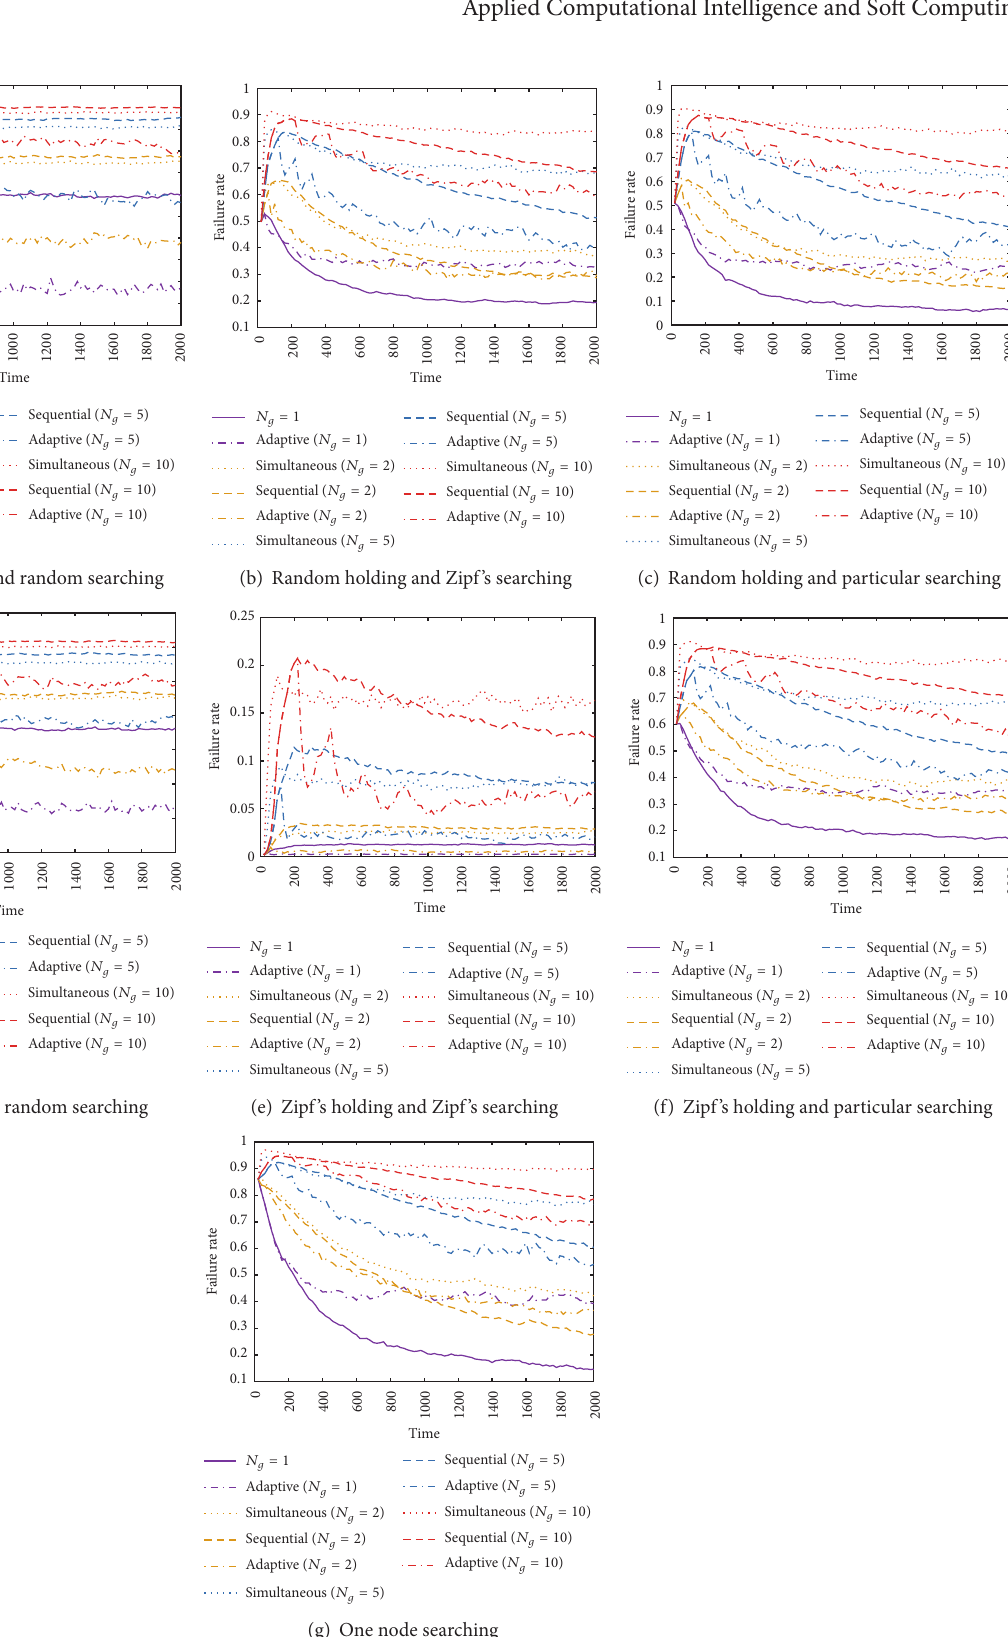
Figure 8: Simulation results of P-EP2P using the sequential and simultaneous topology evaluation methods when all nodes always stay in the